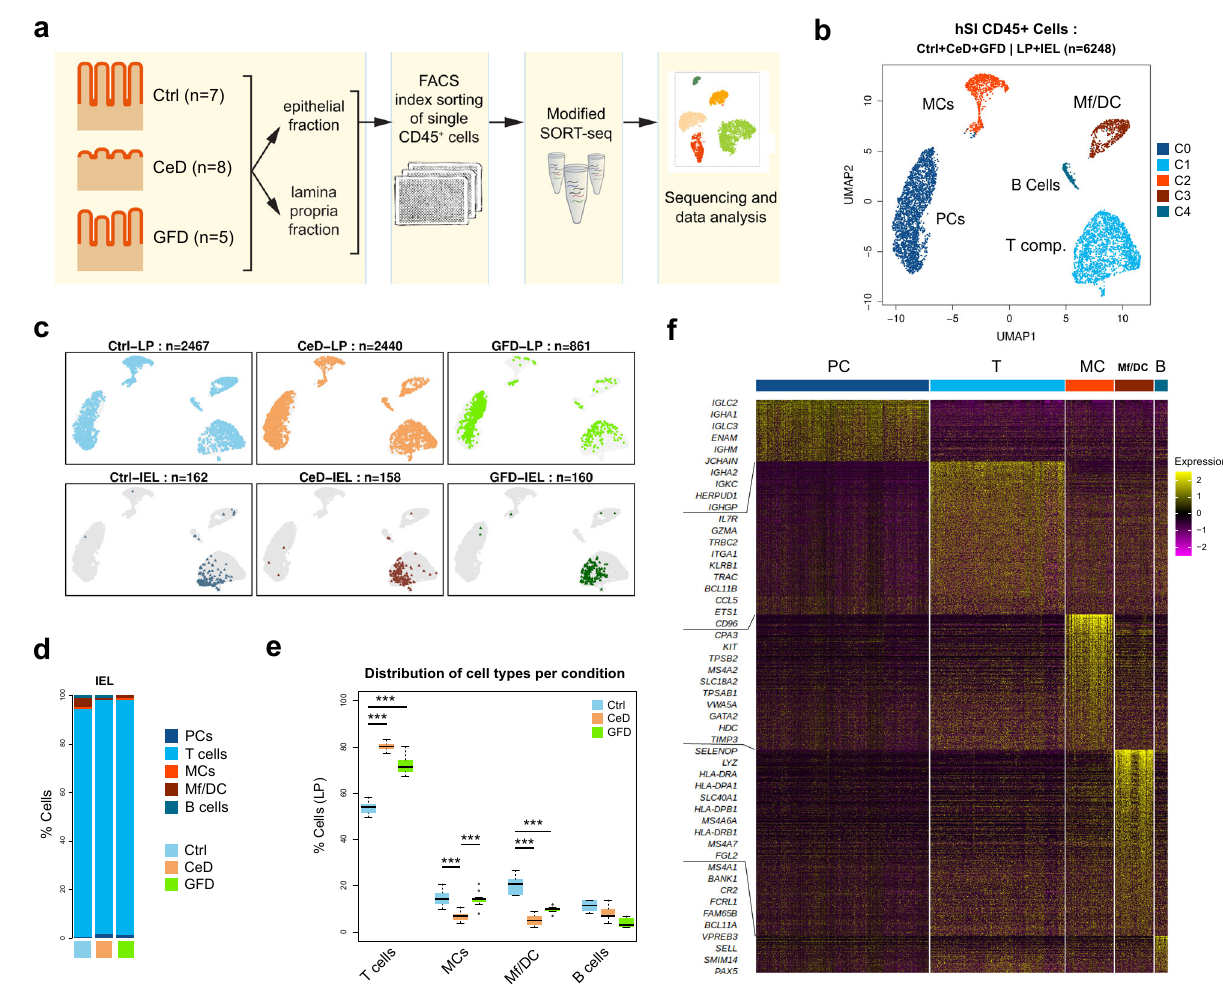
Fig.1|Single-cellCD45 + immunecellsinhumansmallintestineinCtrl,CeDand GFD samples. a Schematic study design b UMAP clustering scatter plot of hSI CD45 + cells based on single cell mRNA expressions (PC Plasma cell, MC Mast cell, Mf/DC Macrophage/Dendritic cell; Ctrl control subjects, CeD Celiac disease sub- jects, GFD Celiac patients on gluten-free diet). c Projectionof the donor status and the origin of the cells (LP vs IEL) on UMAP scatter plots d Bar plots depicting the proportion of the cell types detected within the epithelium of hSI per each con- dition in our single-cell RNAseq dataset e Boxplots showing the cell type related